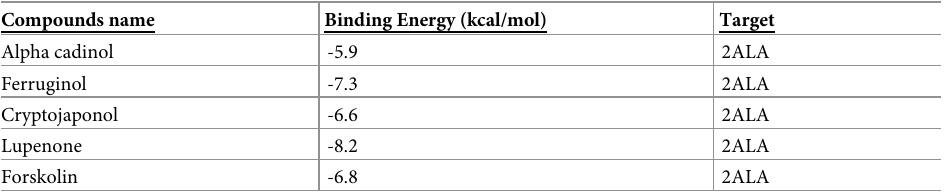
Table 1. Screening of phytochemicals based on their best binding